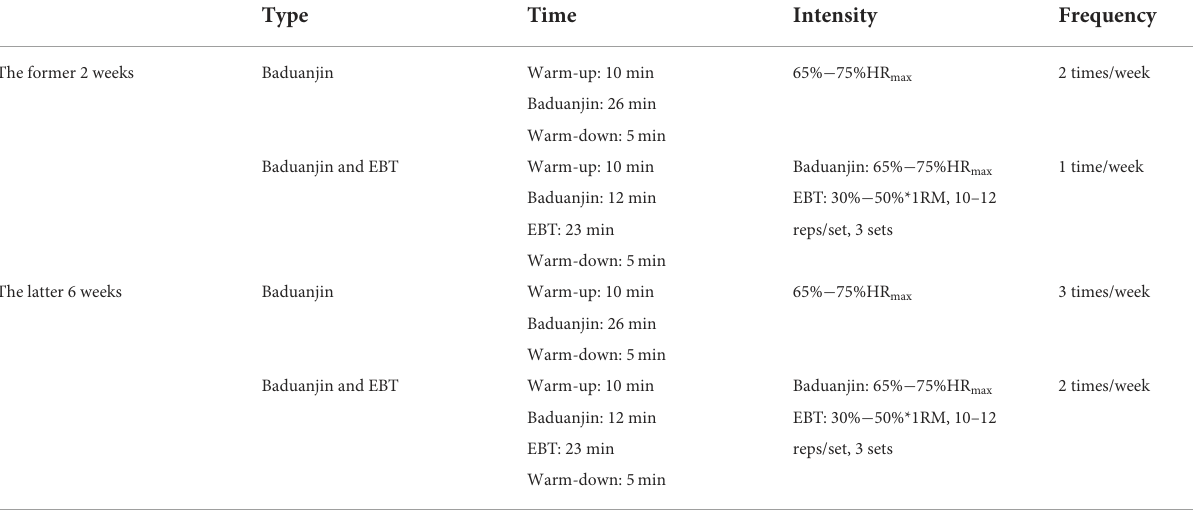
TABLE 1 Details of exercise